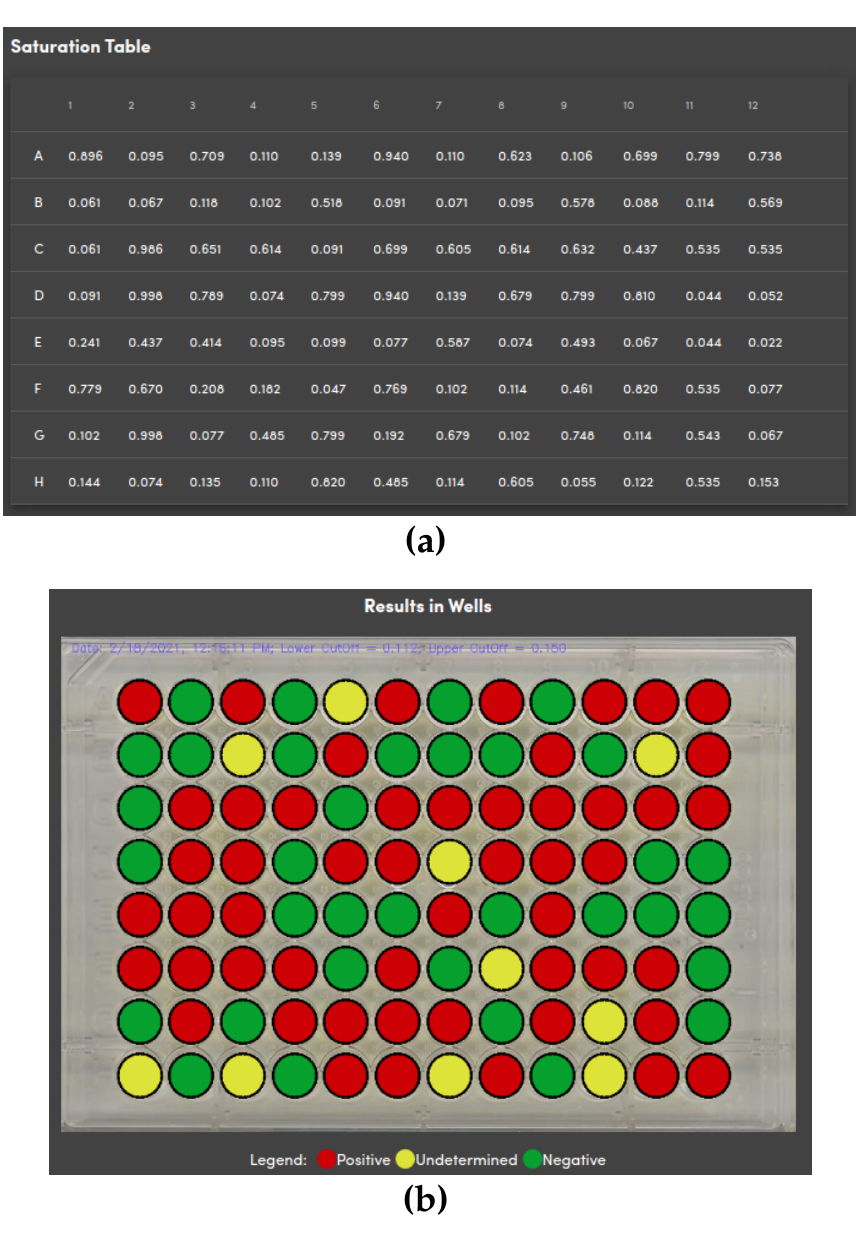
Figure 13. Result generation: ( a ) generated table of diagnosis metrics and ( b ) sample diagnoses presented in the evaluated ELISA plate.